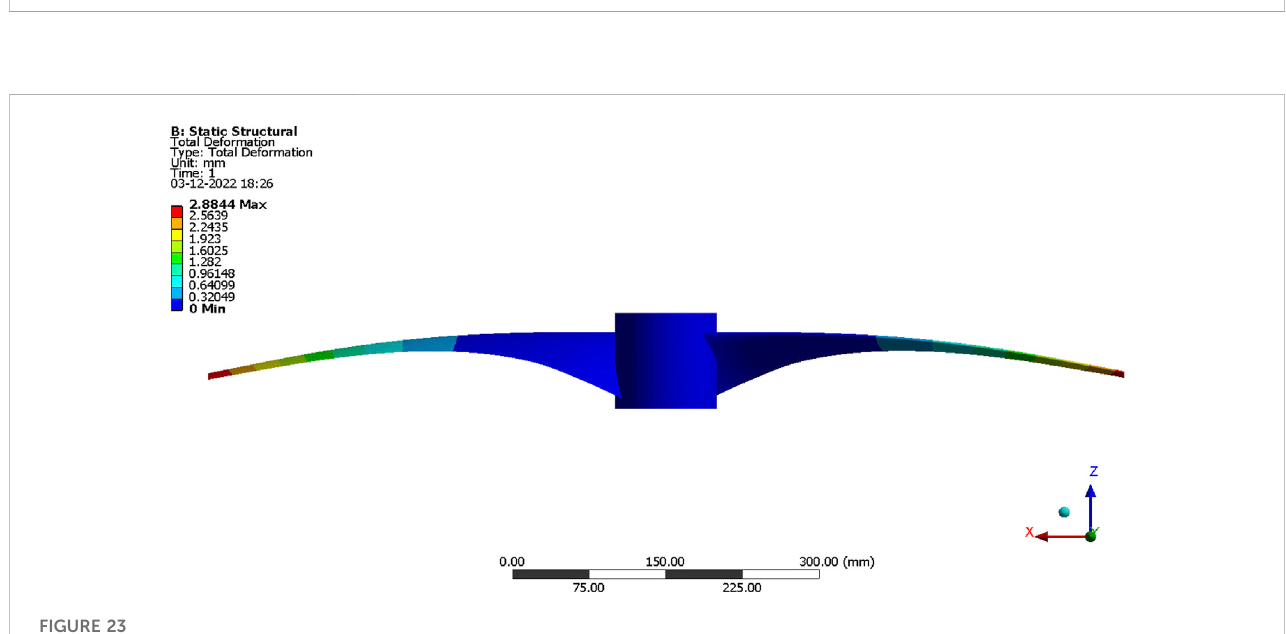
CFRP woven wet – Total